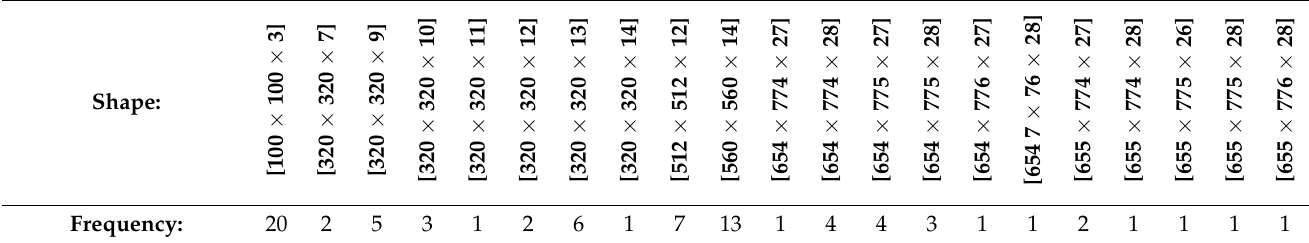
Table 3. Distribution of volume shapes in the dataset. All 80 images are considered. Dimension values for each image should be read from bottom to